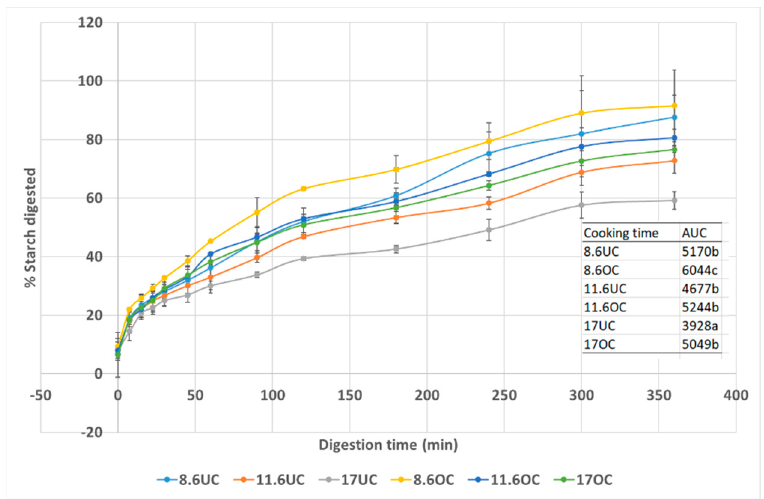
Figure 2. Effect of cooking time in three spaghetti samples with a range in protein content (8.6, 11.6, 17.0%) on starch digestion curves. Data points are mean values (n = 2) with error bars as SD. UC = undercooked pasta FCT ‐ 5 min; OC = overcooked pasta FCT + 10 min; AUC=area under the starch digestion curve.